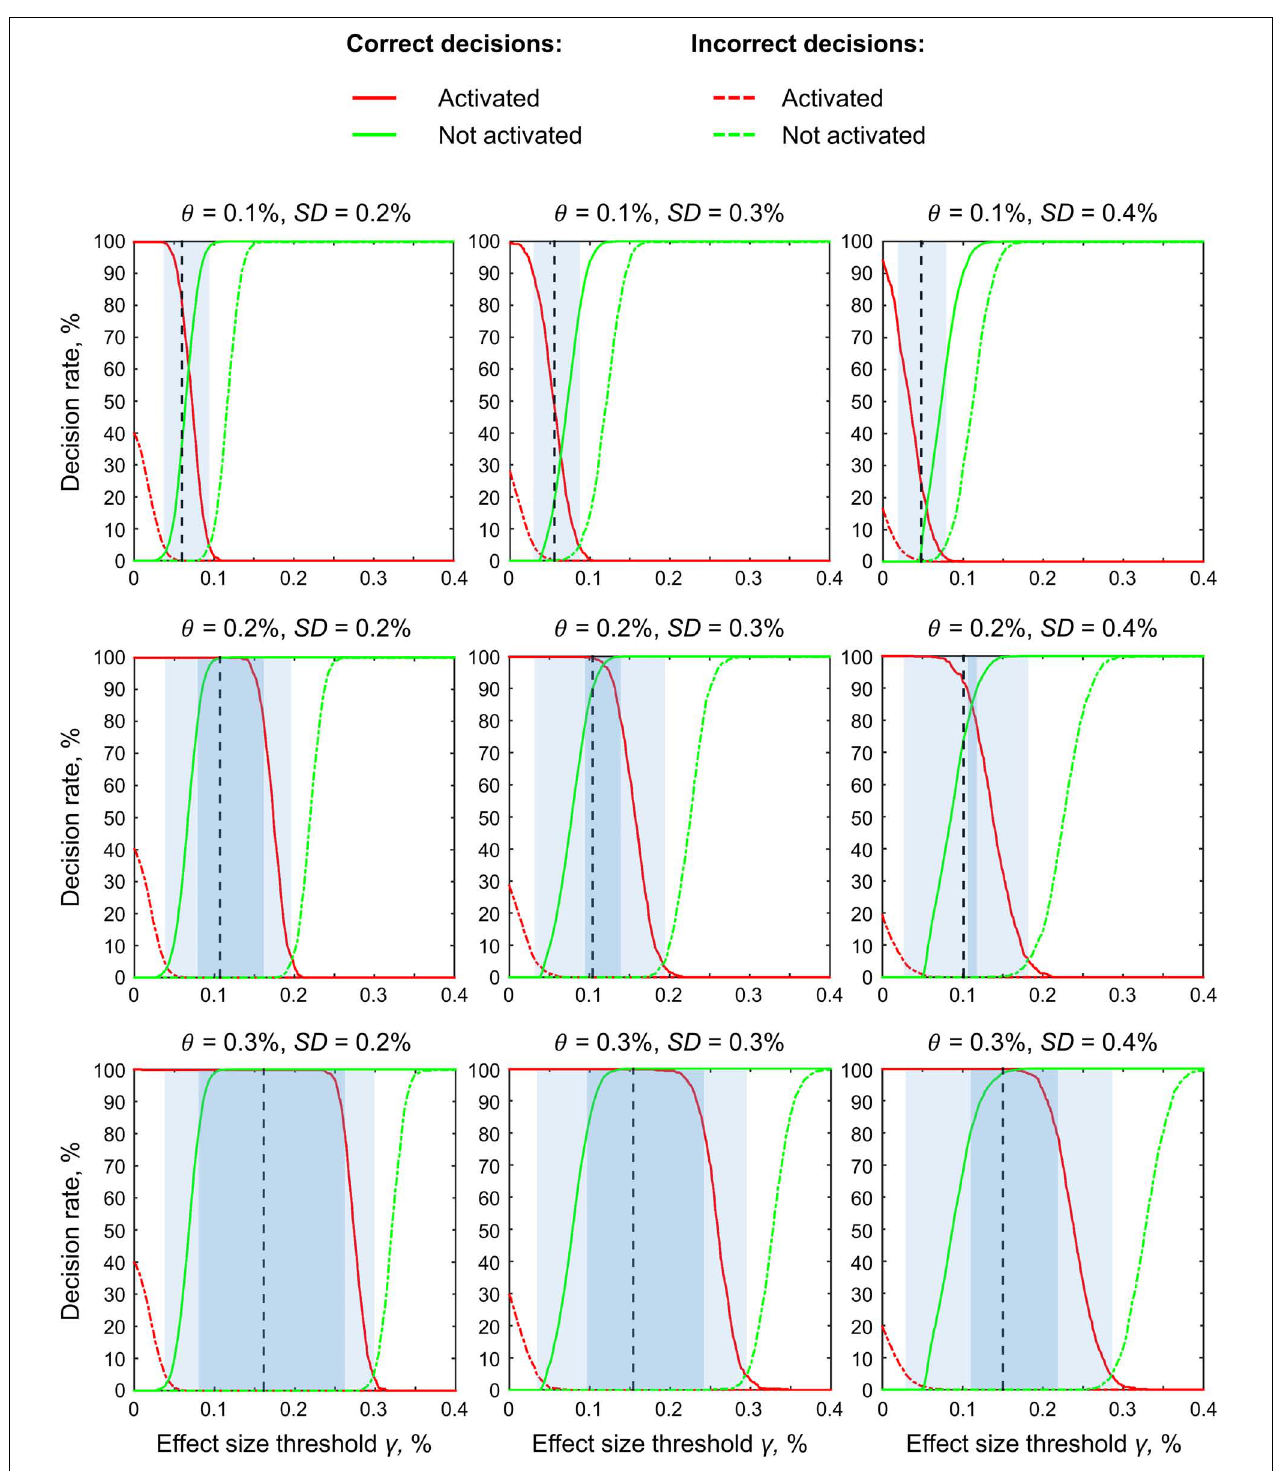
FIGURE 18 | Simulations results for the dependencies of the correct and incorrect decision rates on the ES threshold γ . Data were drawn from normal distributions with different mean effect θ and noise SD . Sample size N = 200 images, results for one random group. The plots for ‘deactivated’ voxels closely follow the plots for ‘activated’ voxels and have therefore been omitted for visualization purposes. Vertical lines indicate the default ES threshold γ = 1 prior SD θ . The light blue areas indicate ES thresholds at which the incorrect decision rates do not exceed 5% for both ‘activated’ and ‘not activated’ voxels. The dark blue areas indicate ES thresholds at which the correct decision rates exceed 80% for both ‘activated’ and ‘not activated’